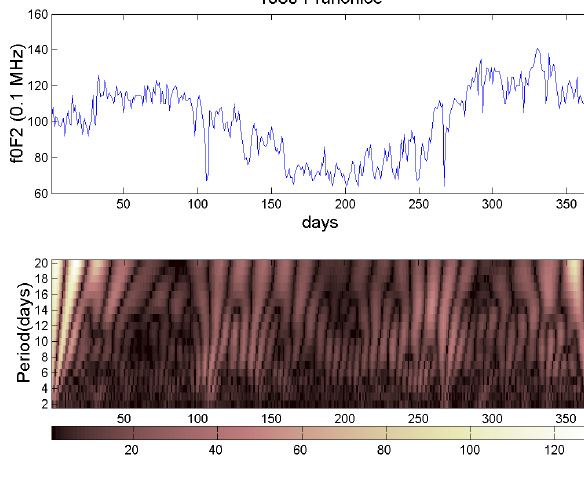
Fig. 1. Planetary wave activity inferred from fo F2 for Pr˚uhonice, January– December 1980, Meyer wavelet trans- form. Top panel, time series of raw fo F2 data. Bottom panel, wavelet transform of the planetary wave activity changing by colour from black-brown (minimum value) to white (maximum value).